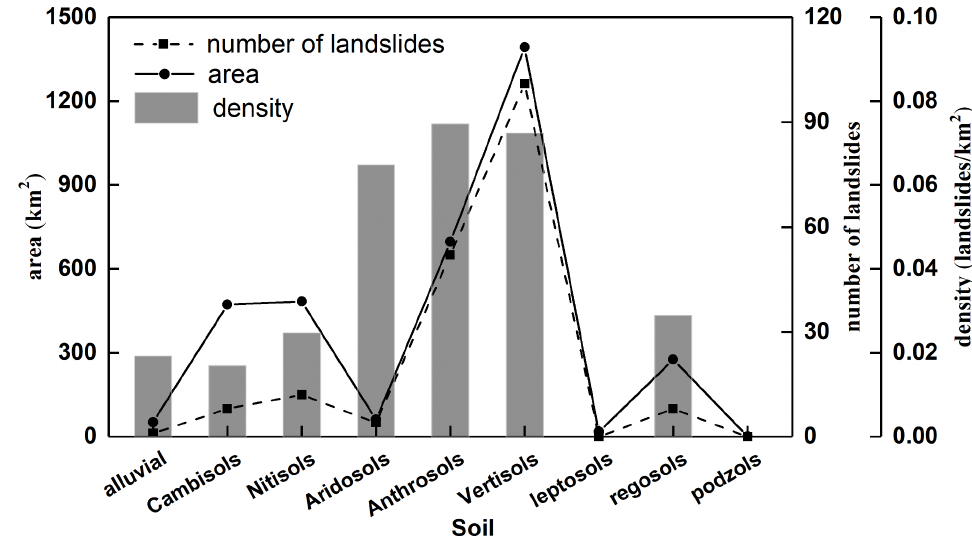
Figure 2. Area and density of landslides according to soil classification. The soil map of the region obtained from the Chinese Academy of Sciences [46], and reclassified according to 9 types of the World Reference Base (WRB) [47].